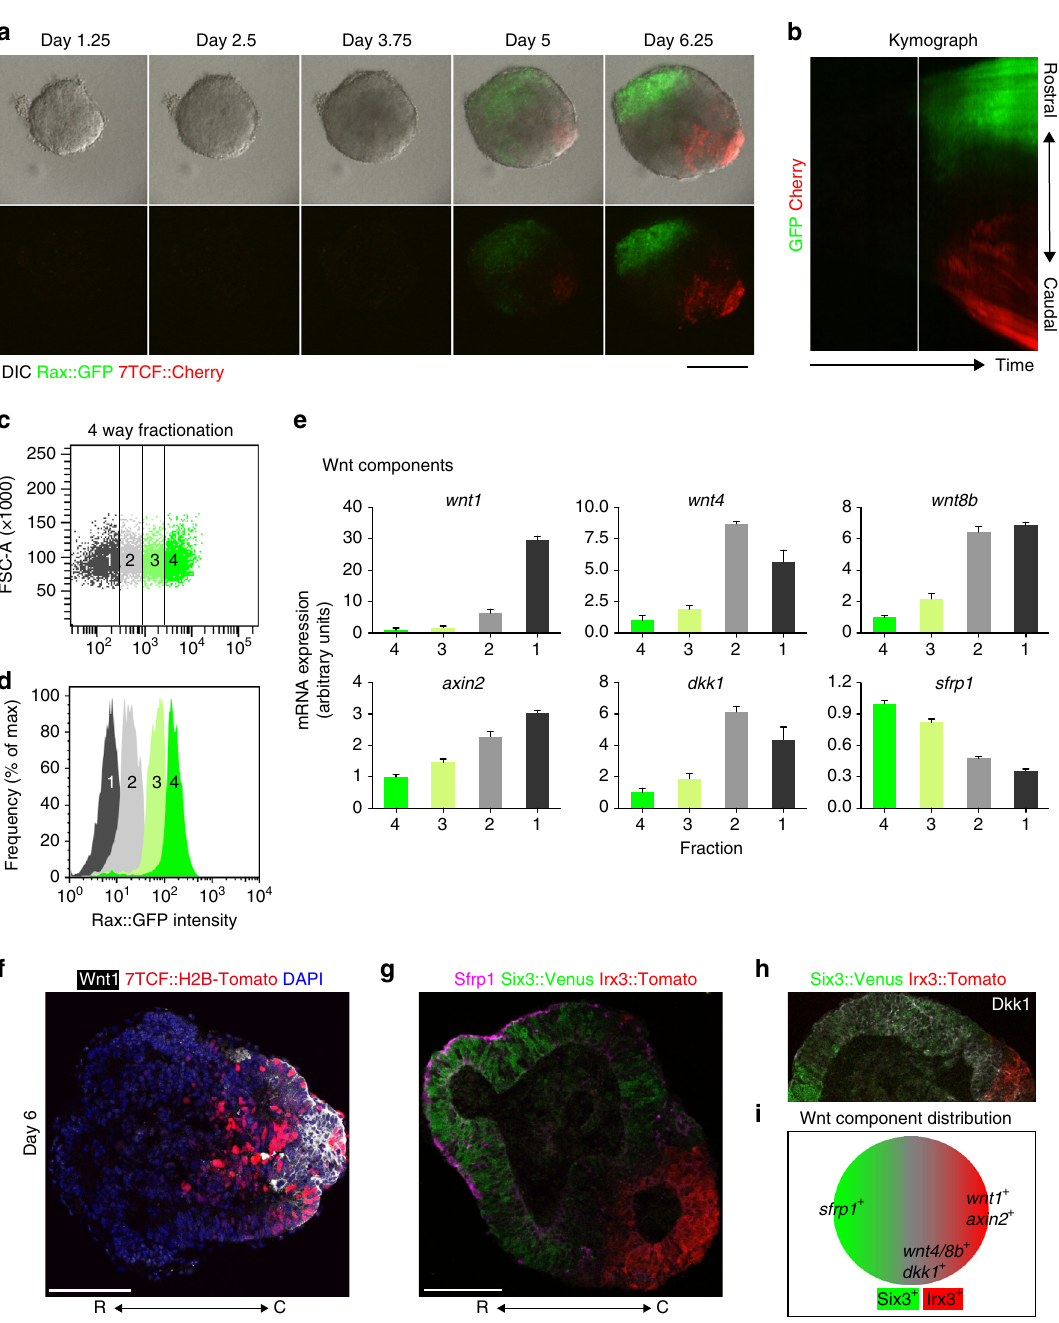
Fig. 5 Wnt signaling components wnt1/4/8b , sfrp1 , dkk1 and axin2 are spatially distributed along the R-C polarized neuroectoderm. a Montage of images taken from Supplementary Movie 5, showing upper panel; merged image of DIC (differential interference contrast), Rax::GFP and 7TCF::Cherry, lower panel; merged image of Rax::GFP and 7TCF::Cherry. b Kymograph analysis of time-lapse images by culture day 7, showing Rax::GFP and 7TCF::Cherry. White solid line indicates the time when Rax::GFP + signals started to polarize. c Four way fractionation of day-6 cells by FACS, depending on Rax::GFP expression levels. d Con fi rmation of four fractions via FACS. e Quanti fi cation of Wnt signaling-related gene expression via RT-qPCR: wnt1 , wnt4 , wnt8b, axin2, dkk1 , and sfrp1 . Error bars indicate s.e.m of each FACS sorting experiment. f , g , h Immunohistochemistry was performed on cryosections of day-6 aggregates, showing Wnt1, 7TCF::H2B-Tomato, Sfrp1, Dkk1, Six3::Venus and Irx3::Tomato expressions. Dkk1 signals in Fig. 5h were also used to show in green in Supplementary Fig. 5J. i Schematic diagram of Wnt component distribution. R, rostral; C, caudal. Scale bars, 100 µ m ( a , f , g ). These images were one of n = 3 experiments ( a , f , g , h We then asked whether the same Wnt signaling ligands identi fi ed in the microarray screen sustain the alternate regional expression in the day-7 aggregates. By FACS-sorting day-7 Rax:: GFP//7TCF::H2B-Tomato cells into GFP + /RFP − and GFP − /RFP + fractions, we found that wnt1 , wnt4, wnt8b , and irx3 were